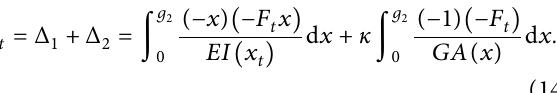
Figure 17: Schematic diagram for calculation of the initial stiffness of stiffened angle steel (units: mm). Table 6: Comparison of the predicted and experimental initial rotational stiffness